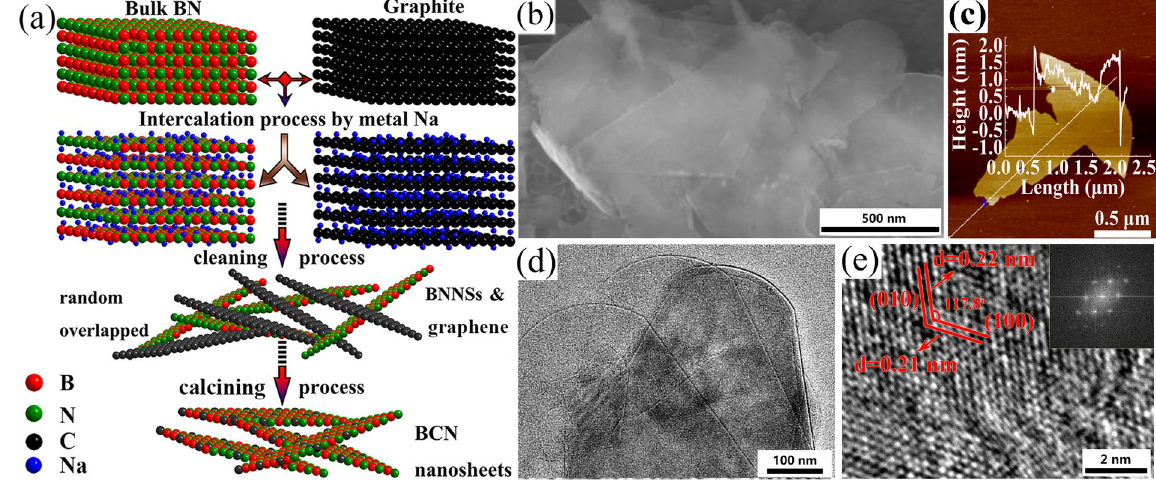
Figure 1. ( a ) Schematic of the processing steps involved in the synthesis of well-dispersed BCN nanosheets. ( b ) SEM image of the as-prepared BCN nanosheets. ( c ) AFM image of the as-prepared BCN nanosheets. ( d